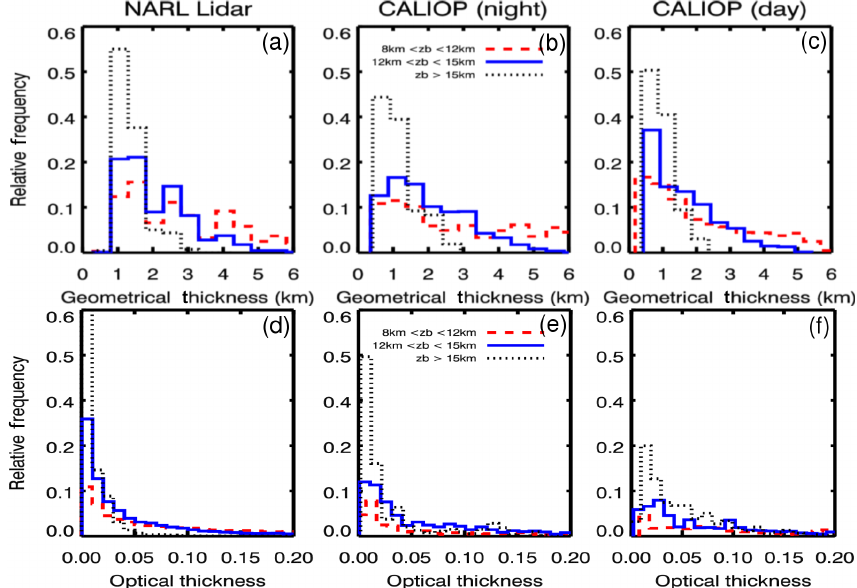
Figure 5. Histograms showing the frequency distribution of geometrical thickness (a–c) and optical thickness (d–f) of cirrus cloud layers with base height ( z b ) in the ranges of 8km< z b <12km (dashed red line), 12km< z b <15km (solid blue line) and z b >15km (dotted black line) obtained from NARL Lidar data ( a and d ) for the period 1998–2013, CALIOP night-time data ( b and e ) and CALIOP daytime ( c and f ) data sets for the period 2006–2013. Bin size for each histogram of geometrical thickness is 0.5km while for optical thickness it is